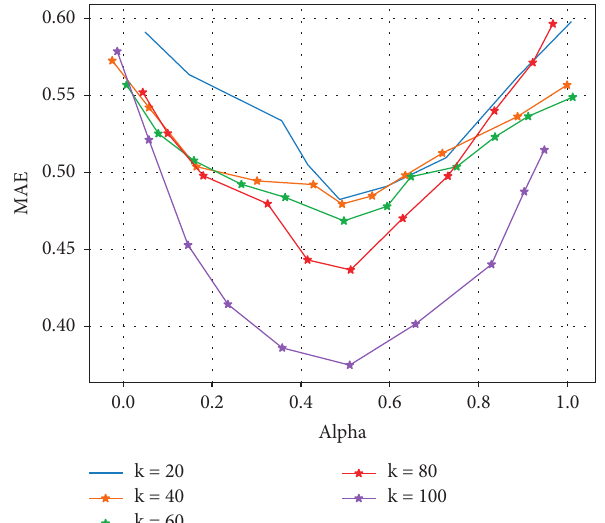
Figure 5: Effect of weighting parameters.